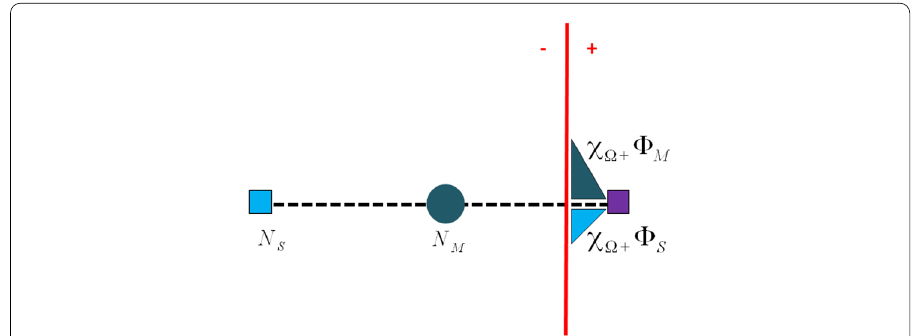
Fig. 16 Coupling between Lagrange quadratic shape functions. When the crack passes close to the nodes, the discontinuous shape functions of the middle node and one vertex node become almost colinear